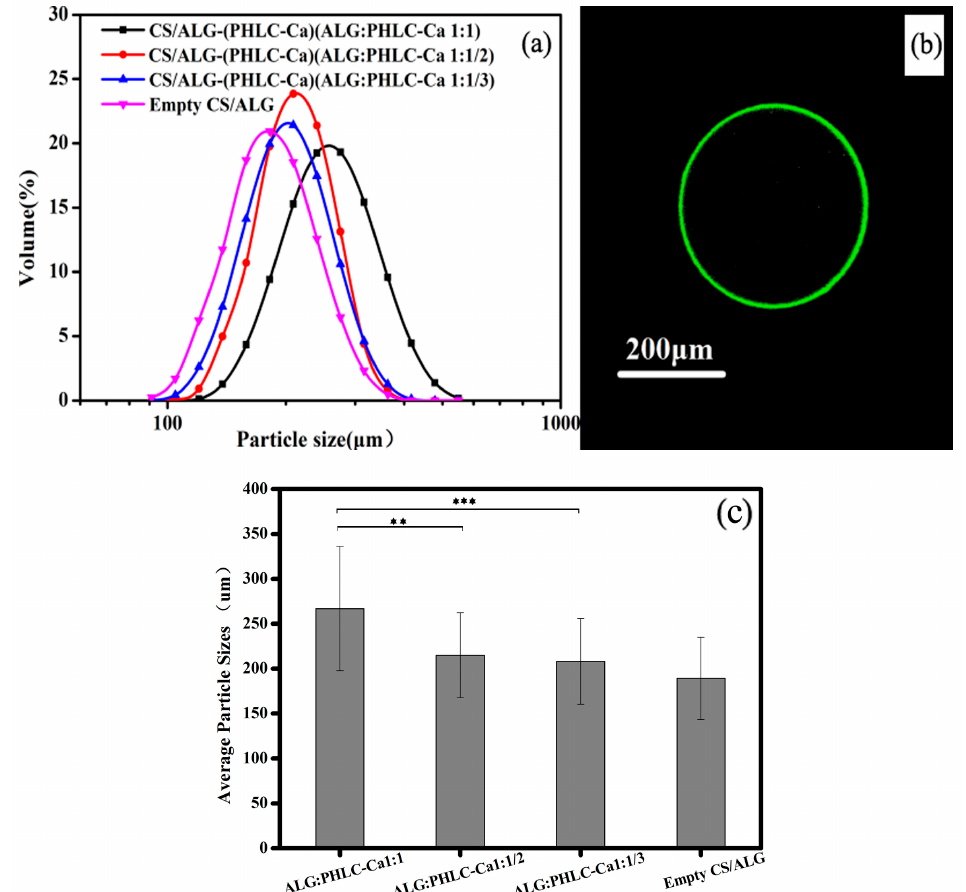
Figure 3. ( a ) Particle size distribution curves of microcapsules; ( b ) confocal laser scanning microscopy (CLSM) images of chitosan (CS) coated alginate (ALG) microcapsules; ( c ) Average particle sizes